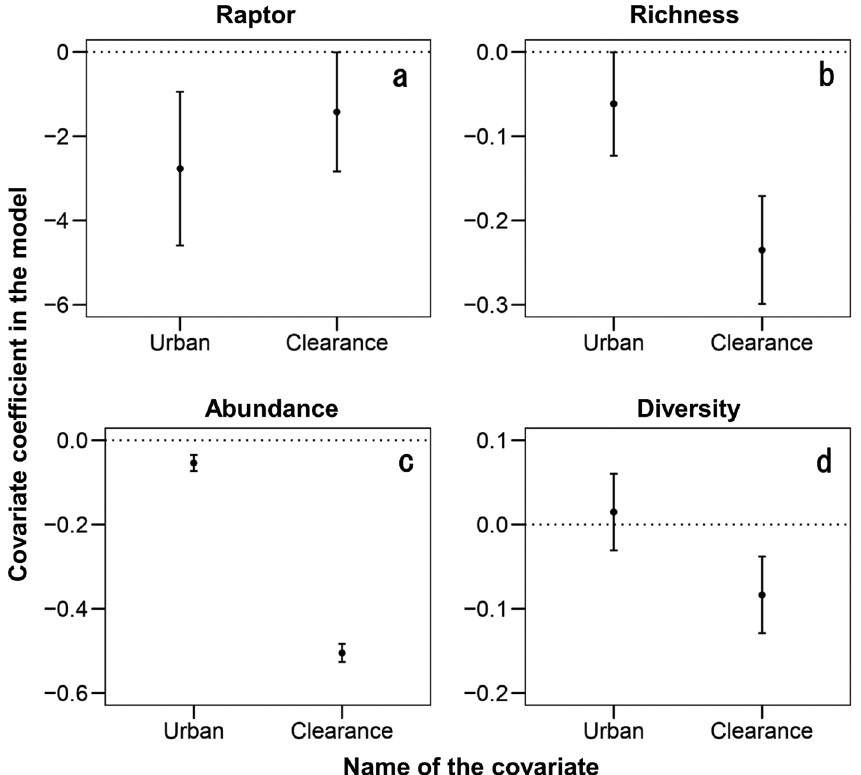
Figure 3. Estimated values of the regression coefficients and their 95% confidence intervals (CIs) from the generalized linear models used to identify the effect of environmental factors (percentage of urban areas and clearance of understory trees) on presence/absence of goshawk breeding sites (raptor, panel a ) and on woody plant species richness (panel b ), abundance (panel c ), and diversity (panel d ). When the 95% CIs excluded zero, the effects of covariates were regarded as statistically